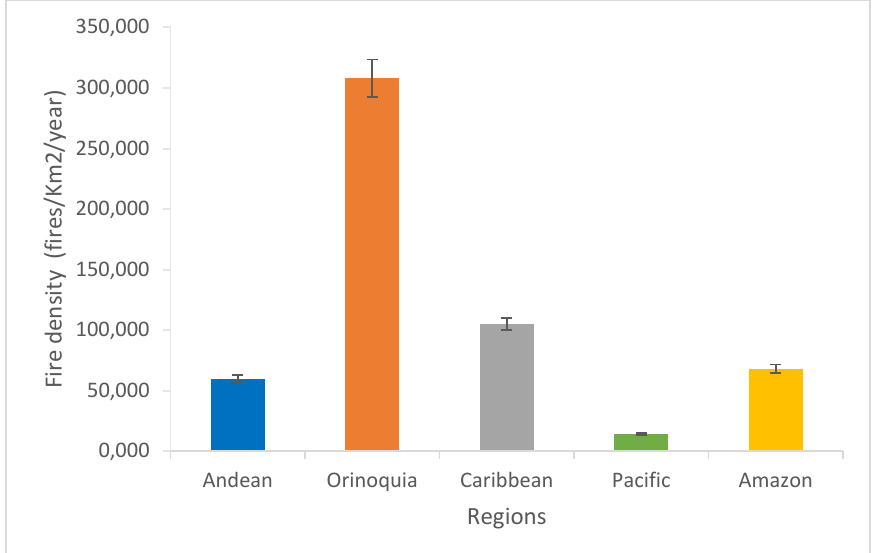
Figure 3. Average fire density per year in natural regions of Colombia over a 21-year period (2000 to 2020).